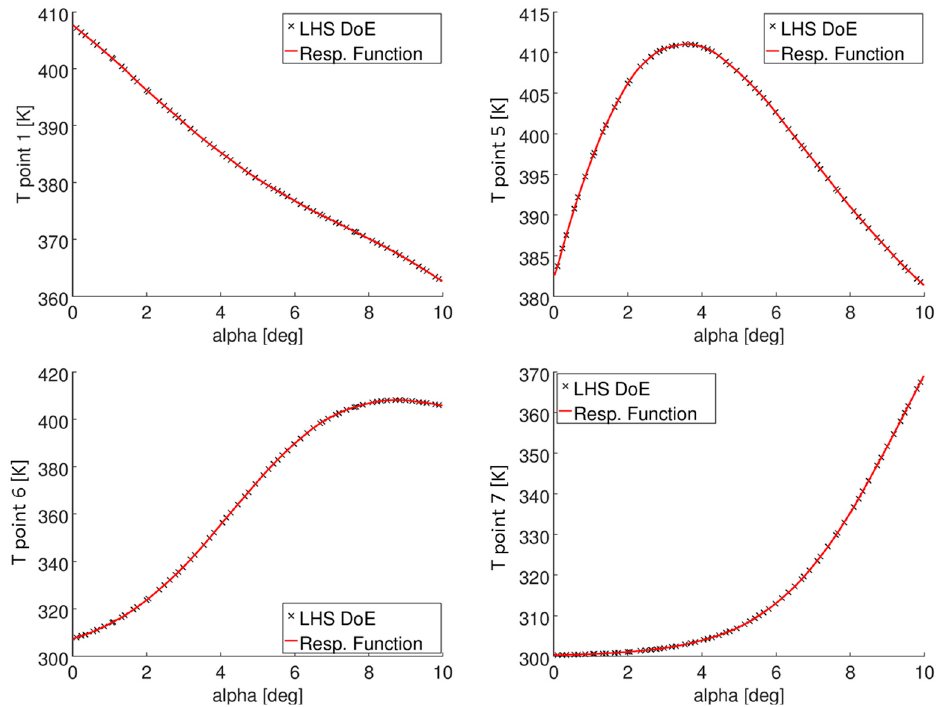
Figure 22. Maximum temperatures from DoE—effect of incoming wind direction.